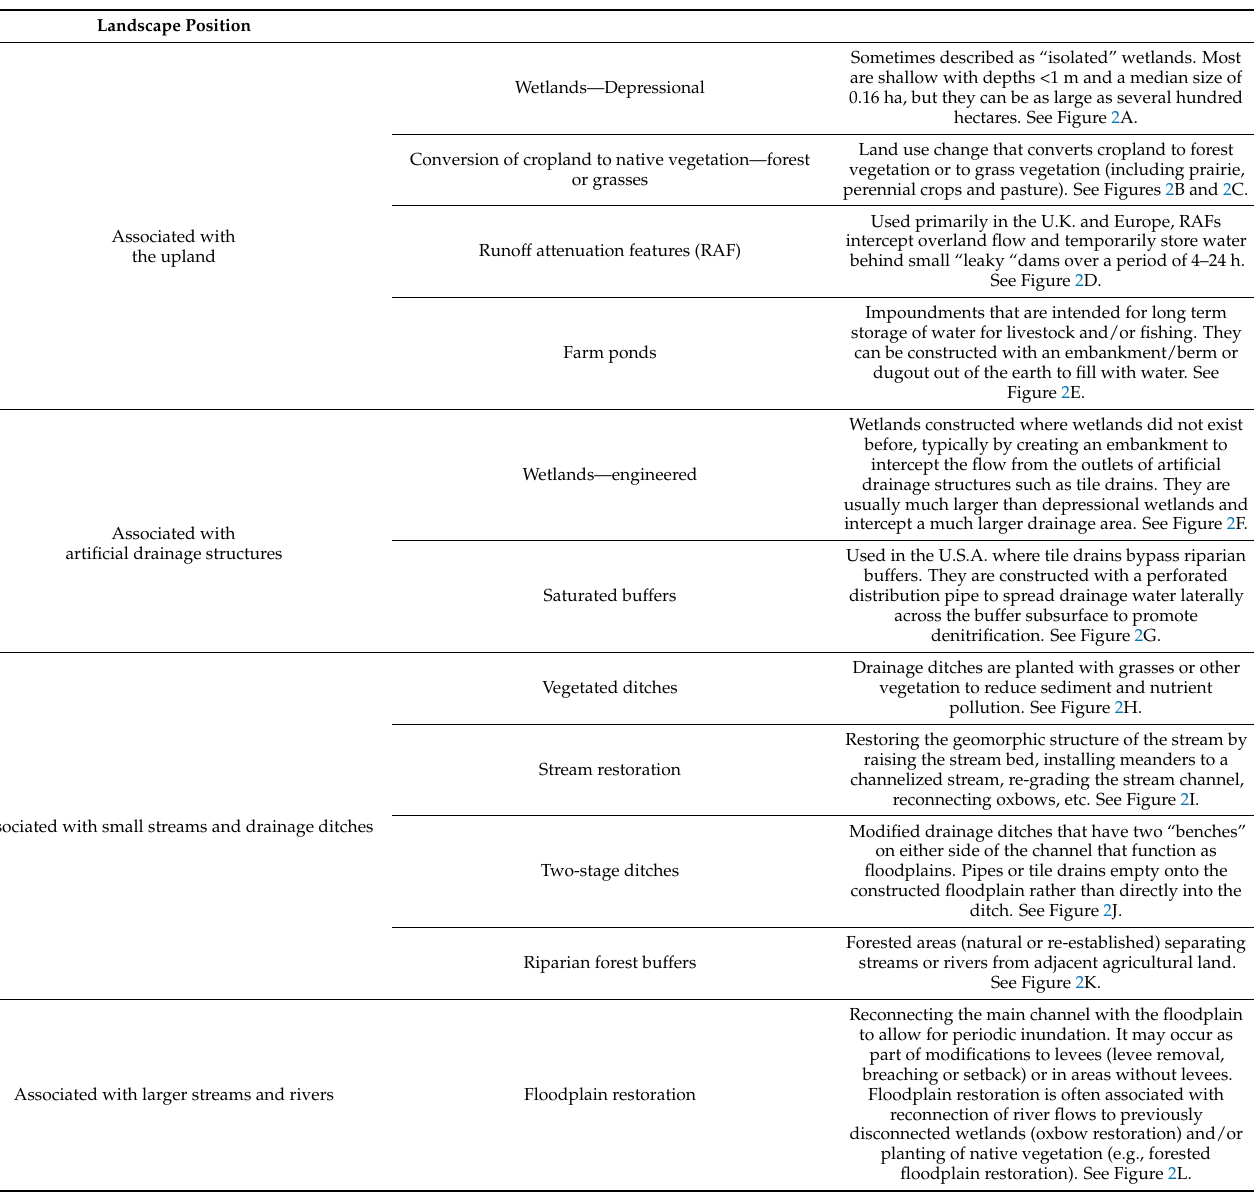
Table 3. Overview of NI measures in agricultural